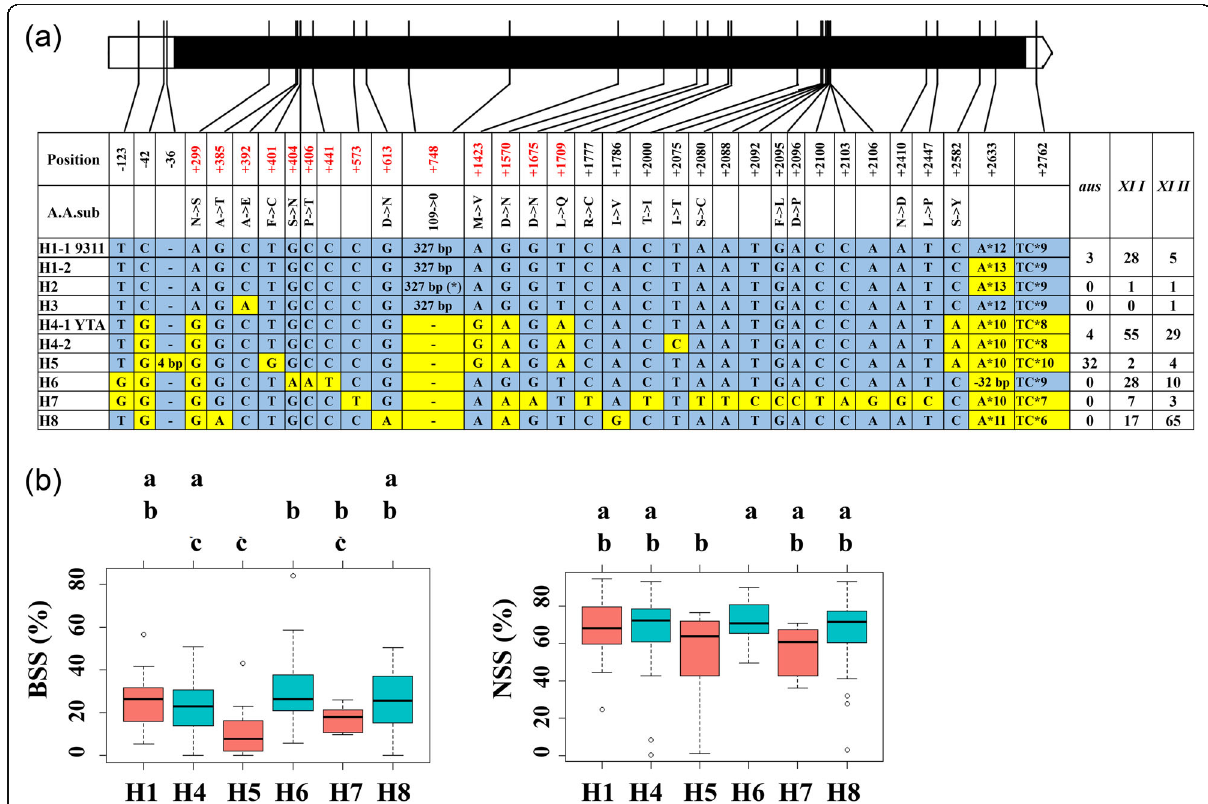
Fig. 6 Haplotype classification and multiple comparisons of Rf6 . In a , red numbers in the Position row indicate selected SNPs to differentiate different haplotypes in the partial sequencing of Rf6 . The H2 type carries a SNP in the 327bp insertion that produces a stop codon. In b , superscript letters indicate statistically significant differences among mean values of different haplotypes in year 2014, with Rf5 fixed as the H1 type (Tukey test, P <0.05). The numbers of F 1 lines carrying the six haplotypes was 30, 58, 12, 28, 6 and 73,